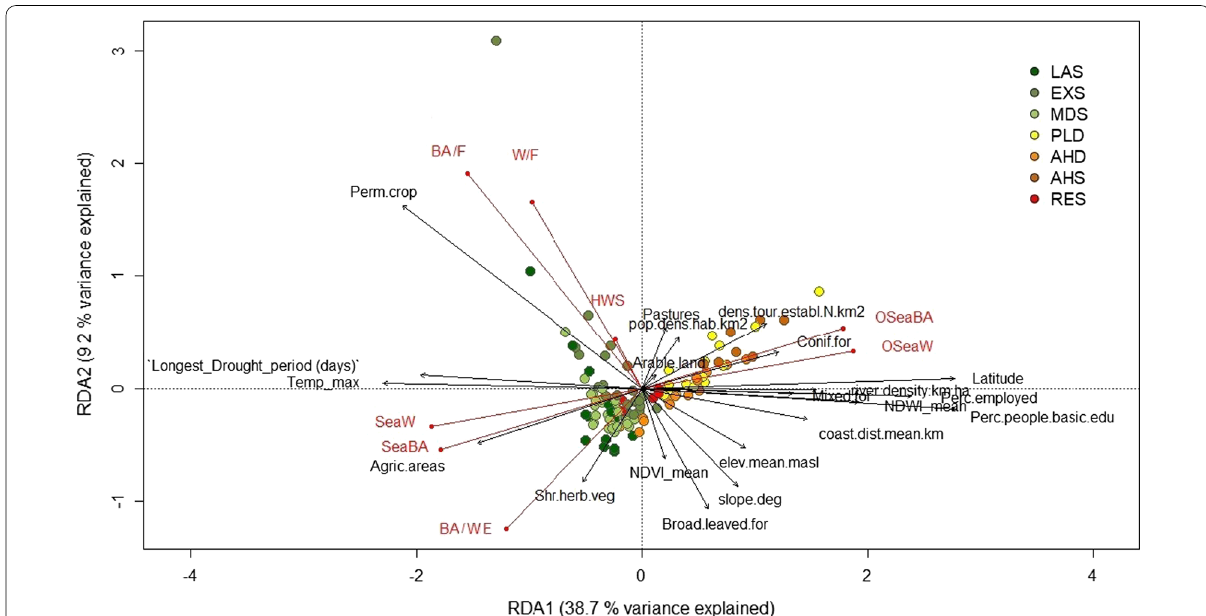
Fig. 5 Biplot relationships between wildfire metrics (red text) and biophysical, socioeconomic and climatic variables (black text) of NUTS3 provinces in Italy. Each dot represents a NUTS3 province, and the colors denote belonging to a pyroregion: Large summer wildfires (LAS); Extreme stand-replacing summer wildfire (EXS); Medium density summer wildfires (MDS); Subalpine low density wildfires (PLD); Alpine high density wildfires (AHD); Alpine High Stand-replacing wildfires (AHS); and Reduced stand-replacing wildfires (RES). The arrow length and direction represent the variance that can be explained by the variables. The direction of an arrow suggests an increasing magnitude of the variable, while the perpendicular distance between orders and variable axes in the biplot represent their correlations (All variables are reported in Table